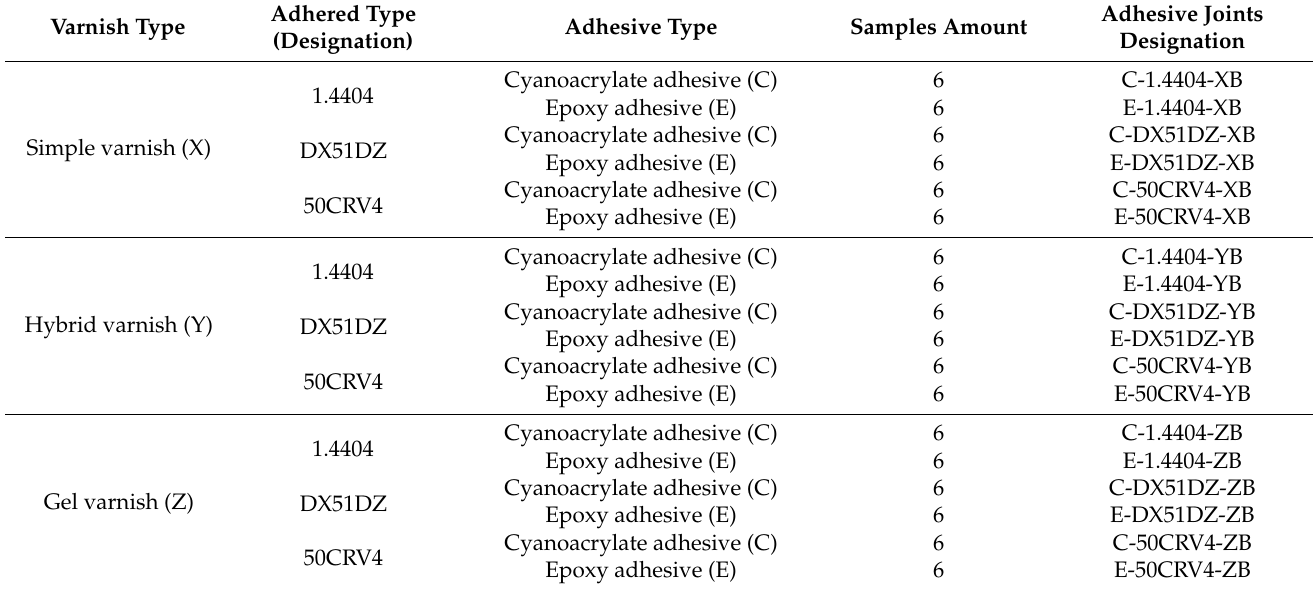
Table 7. Designations of adhesives joints—variant B of surface